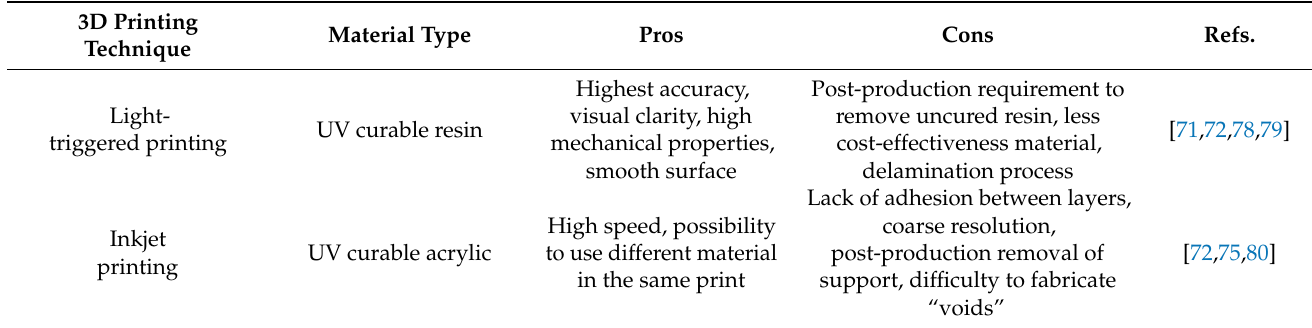
Table 3. Short overview about main 3DP techniques advantages and drawbacks.